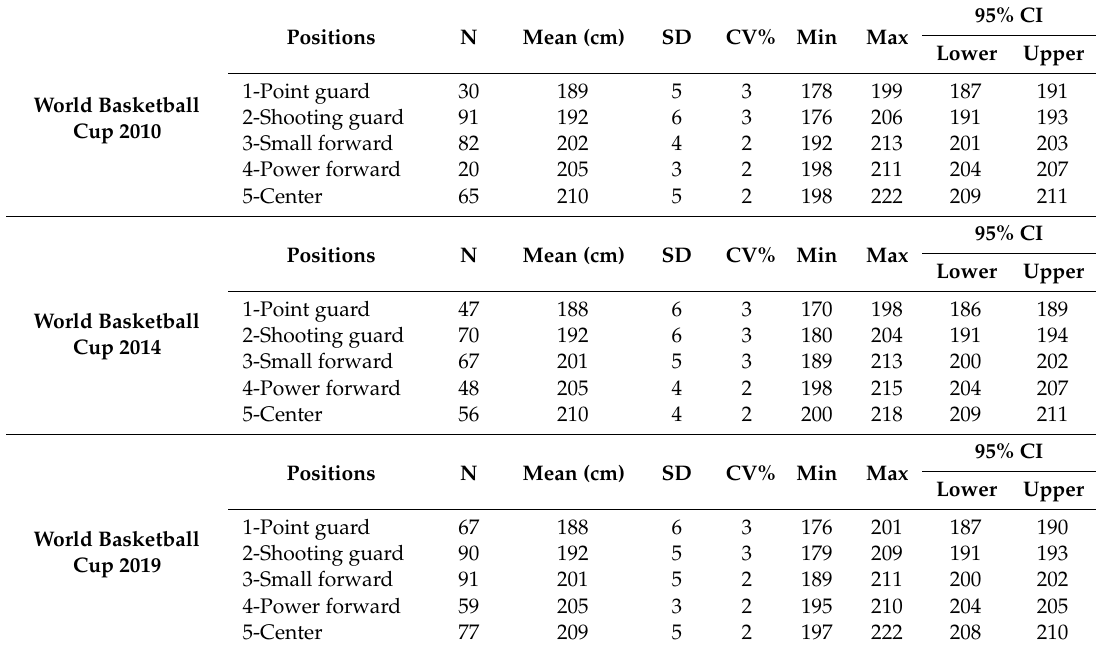
Table 1. Body height of basketball players from three FIBA-WCs relative to position in team.